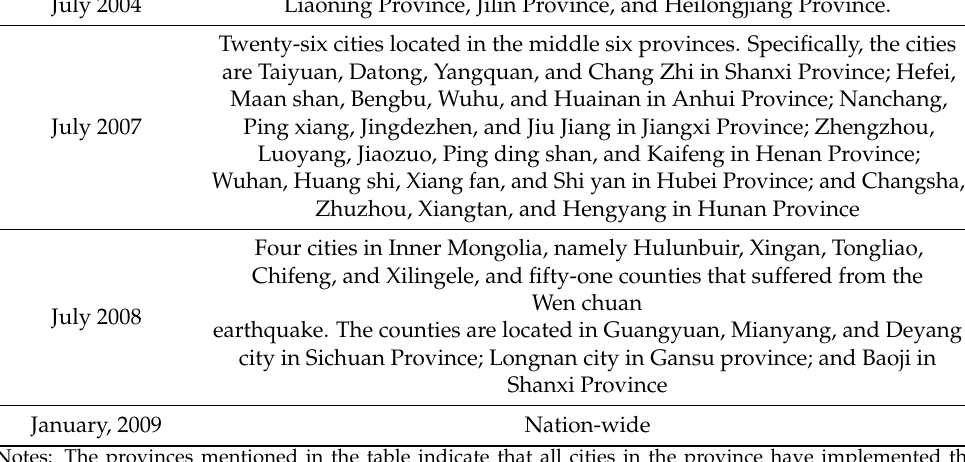
Table 1. Date and city of VAT